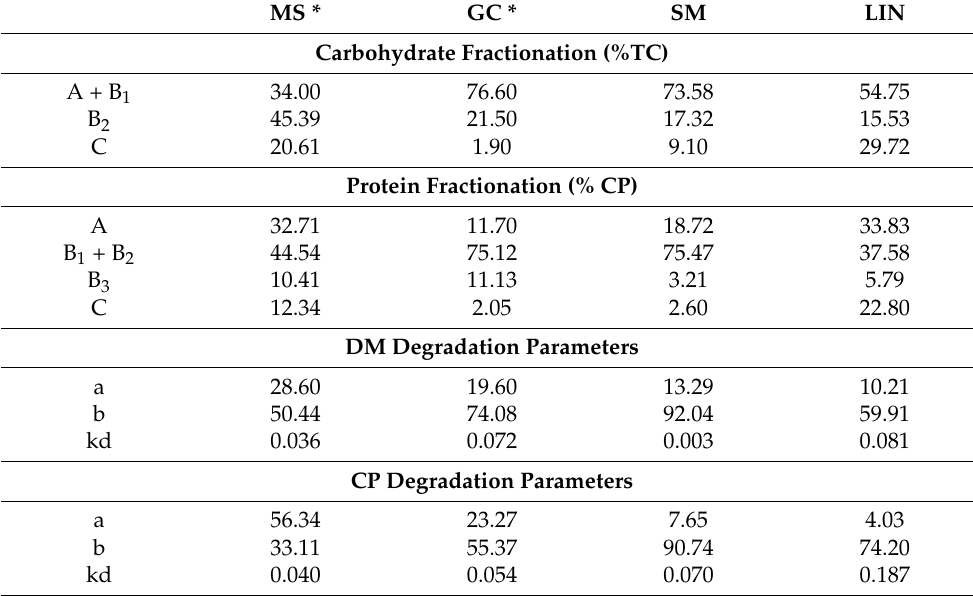
Table 2. Carbohydrate and protein fractionation, and degradation parameters of DM, CP, NDF from cottonseed